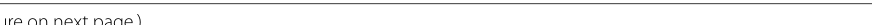
figure on next Fig. 2 Relative proportion contribution of autotrophic sources to the nutrition of fish in the Pangani Estuary. The box plots represent 25% (white), 75% (grey) and 95% (black) credibility intervals of autotrophic sources to the fish nutrition, CC, Carangoides chrysophrys and EM, Epinephelus malabaricus caught in a upper, b middle and c lower estuarine zones. Autotrophic sources included sPOM surface particulate organic matter (sPOM), Fgpr combined filamentous green algae and periphyton, Sgsw combined macro-algae ( Sargassum species) and sea grass, C4pl C 4 plants, C3pl C 3 plants including mangroves, and Mpb